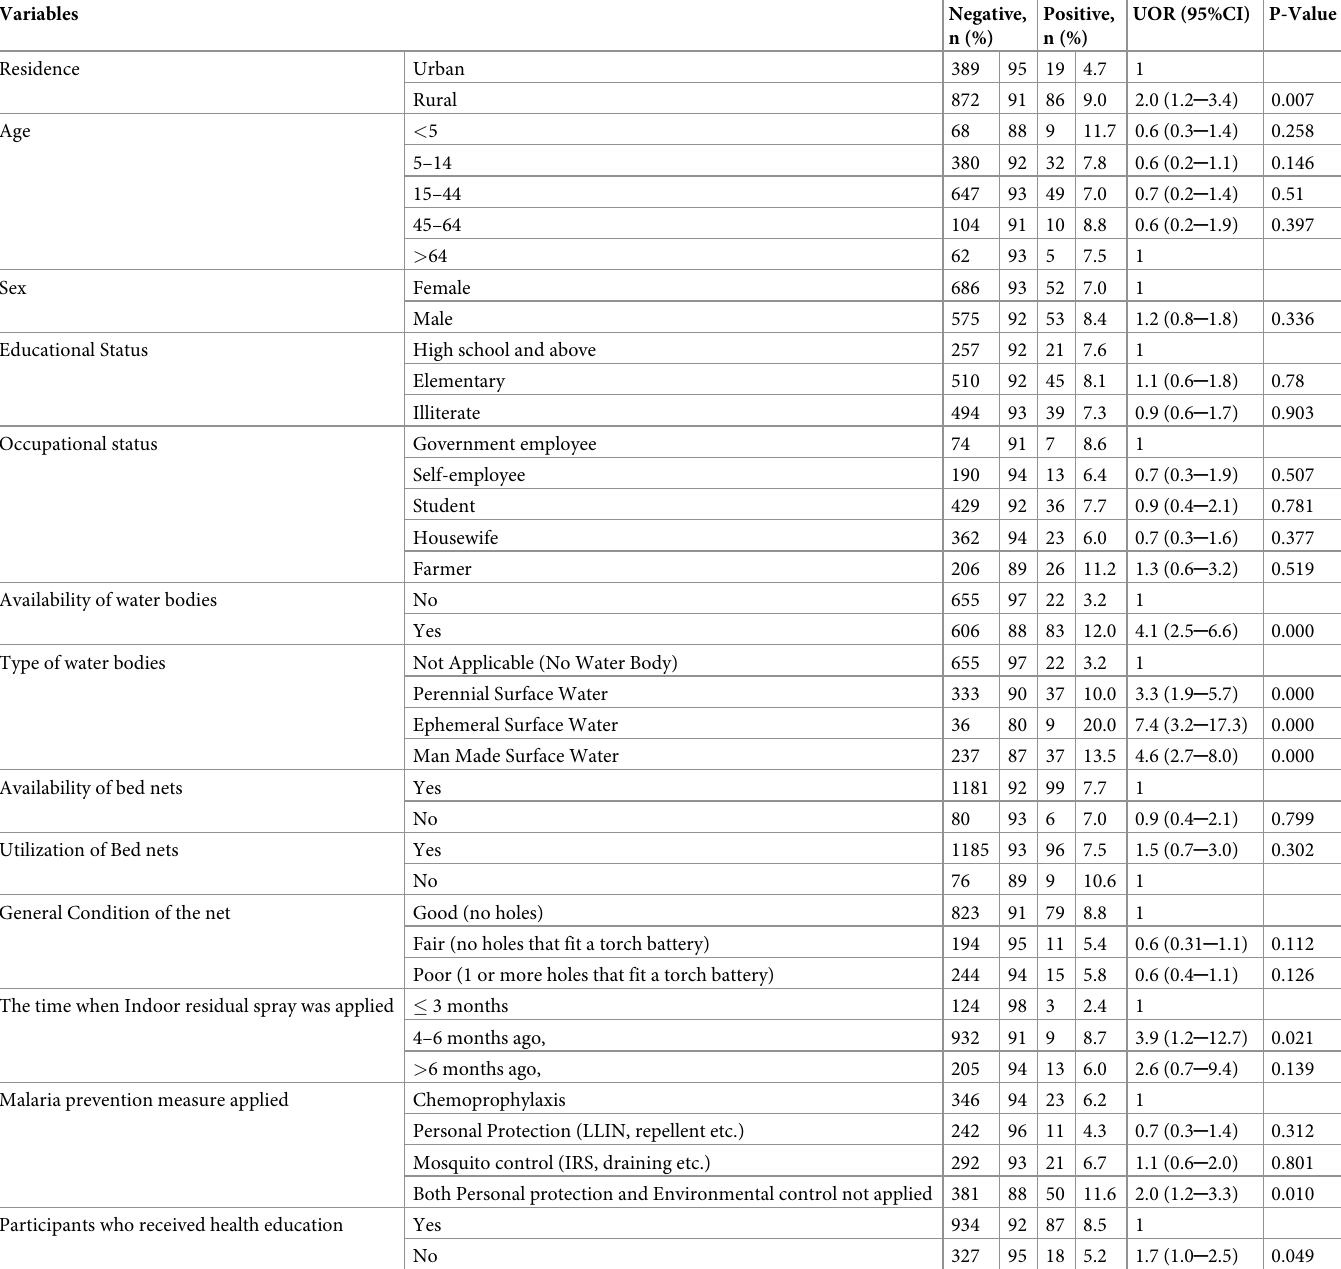
Table 2. Bivariate analysis of nurturing factors associated with asymptomatic malaria infection.